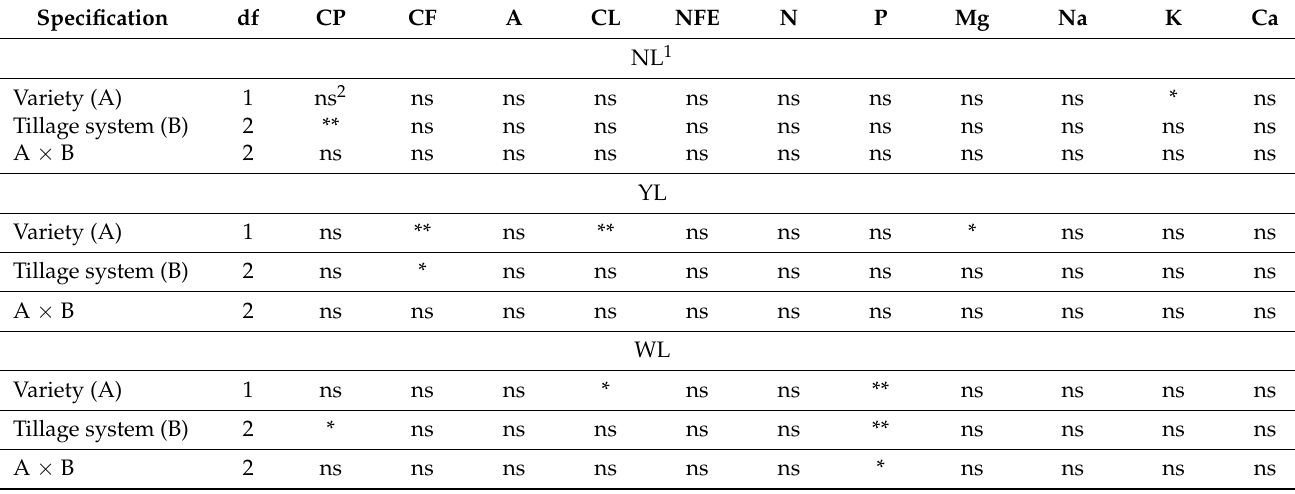
Table 1. Factorial ANOVA with variety, tillage system and interaction for the content of organic components, ash and macroelements in